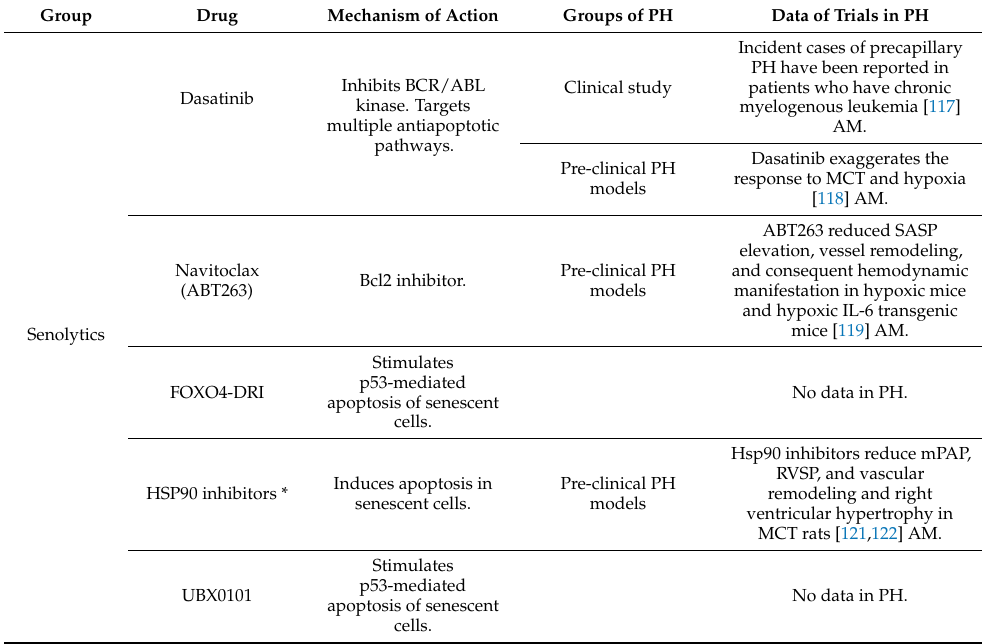
Table 5. Overview of the various classes of drugs that have been developed as senotherapies. Some of these drugs have already been evaluated in the context of